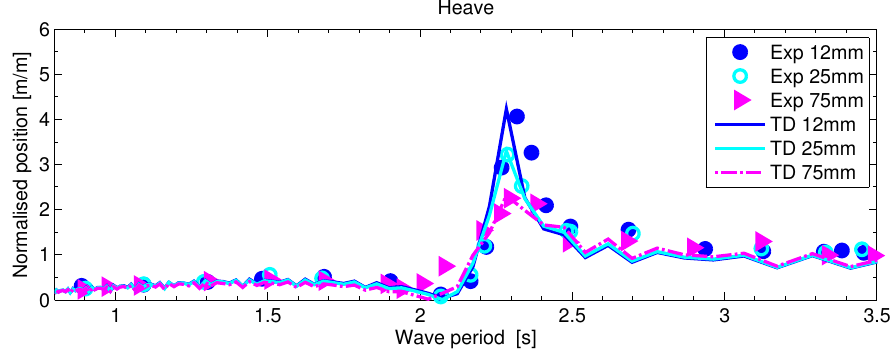
Figure 3. Evaluation of the drag coefficient C d from the curve fitting exercise. Here, Exp represents experimental results adapted from [18], with permission from ASME, 2014, and TD represents the time domain computational model with C d =